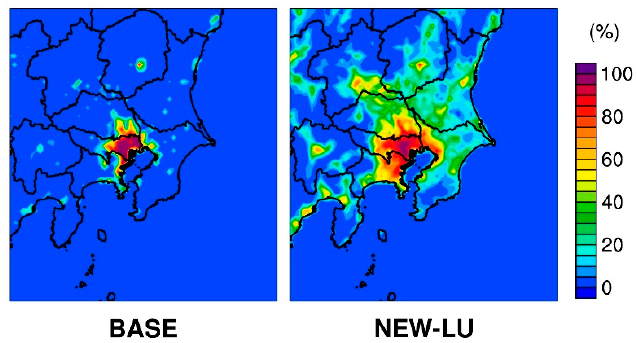
Figure 4. Urban land use percentage, as input to the BASE and NEW-LU cases in d04.